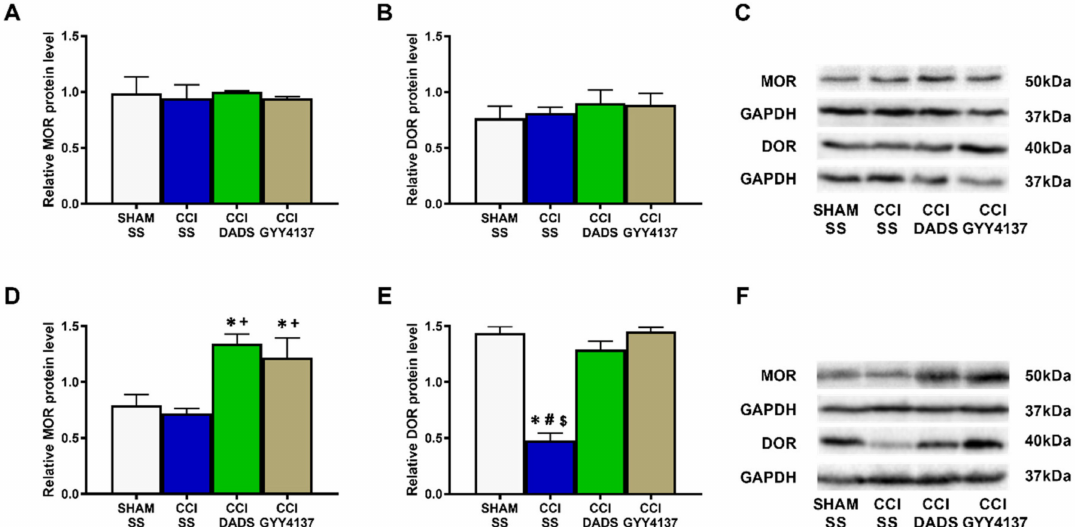
Figure 8. The influence of DADS and GYY4137 treatments on the expression of MOR and DOR in the MS and DRG of mice with neuropathic pain. Both treatments did not alter the protein levels of MOR ( A ) and DOR ( B ) in the MS, increased the expression of MOR ( D ), and avoided the down-regulation of DOR ( E ) in the DRG. Sham-operated (SHAM) mice treated with SS were used as control groups. MOR and DOR levels are expressed in relation to GAPDH. Blots for MOR and DOR in the MS ( C ) and DRG ( F ) are presented. In all pictures, * denotes significant changes vs. SHAM-animals injected with SS; + vs. CCI-mice injected with SS; # vs. CCI-mice injected with DADS; and $ vs. CCI-mice injected with GYY4137 ( p < 0.05; one-way ANOVA followed by Tukey test). Each column represents the mean, and vertical bars indicate SEM ( n = 3